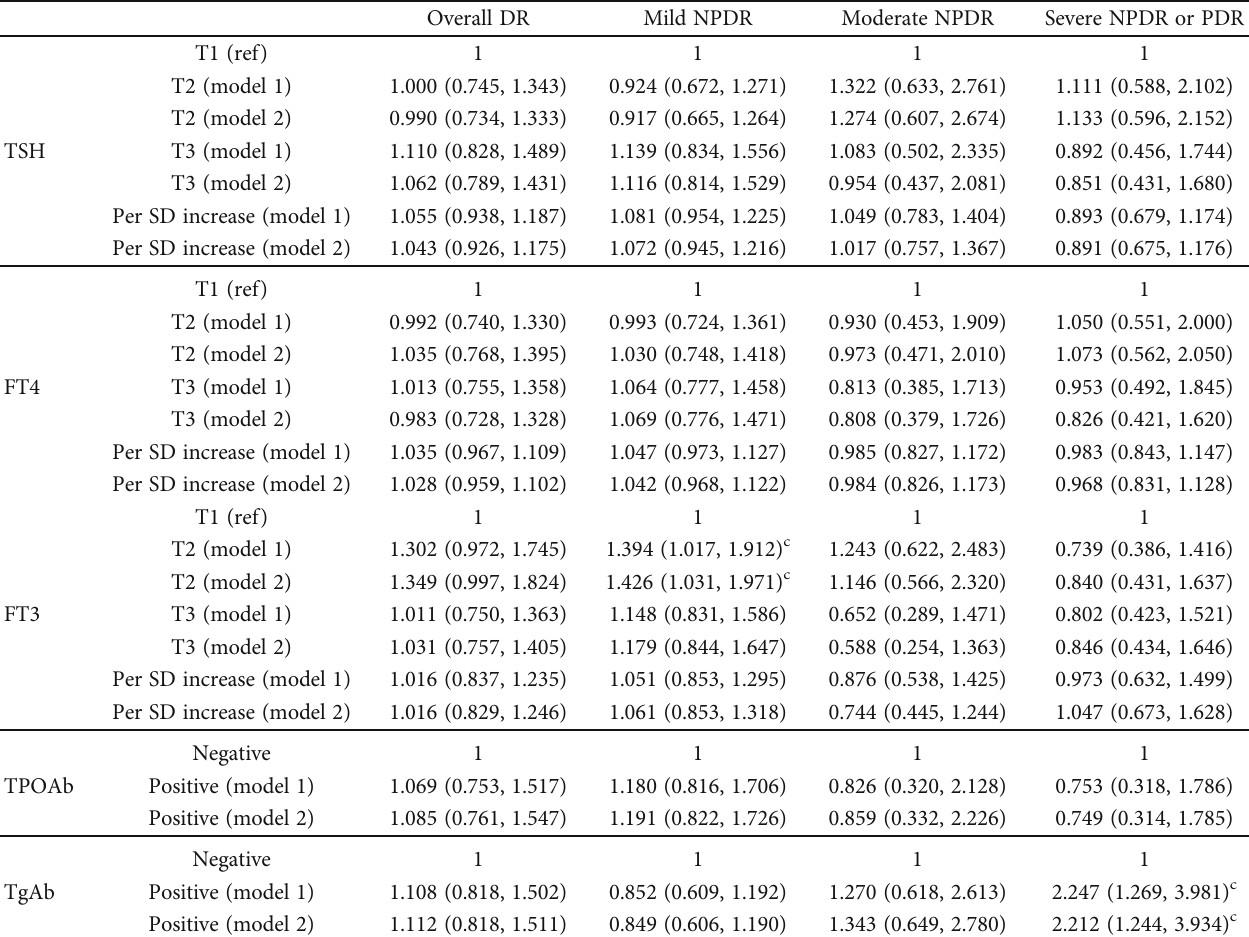
Table 3: Associations between thyroid indicators and various stages of DR